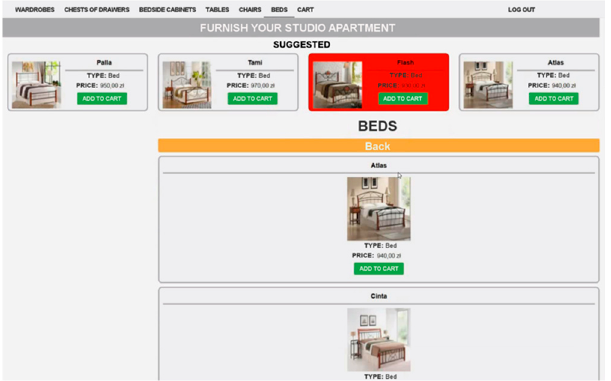
Figure 6. Example of visual intensity VI3 (red background) in the vertical recommending interface.